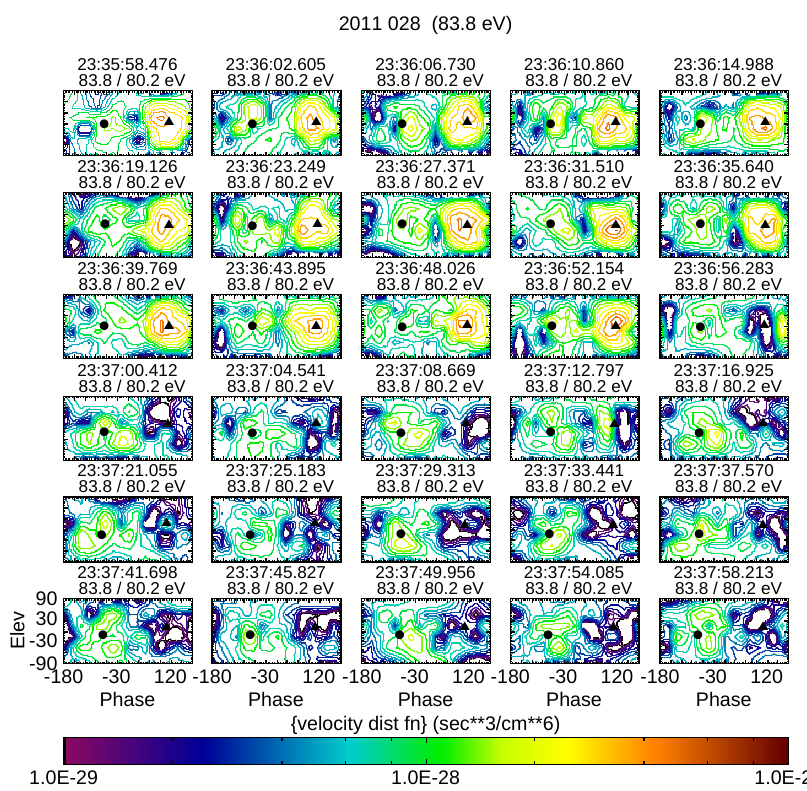
Figure 15. Contiguous temporal set of φ – θ plots at 83.8eV showing the rapid transition from a region with a strahl to one without. Time starts at the top left and runs to the right from top to bottom. The entire set of plots is from within the